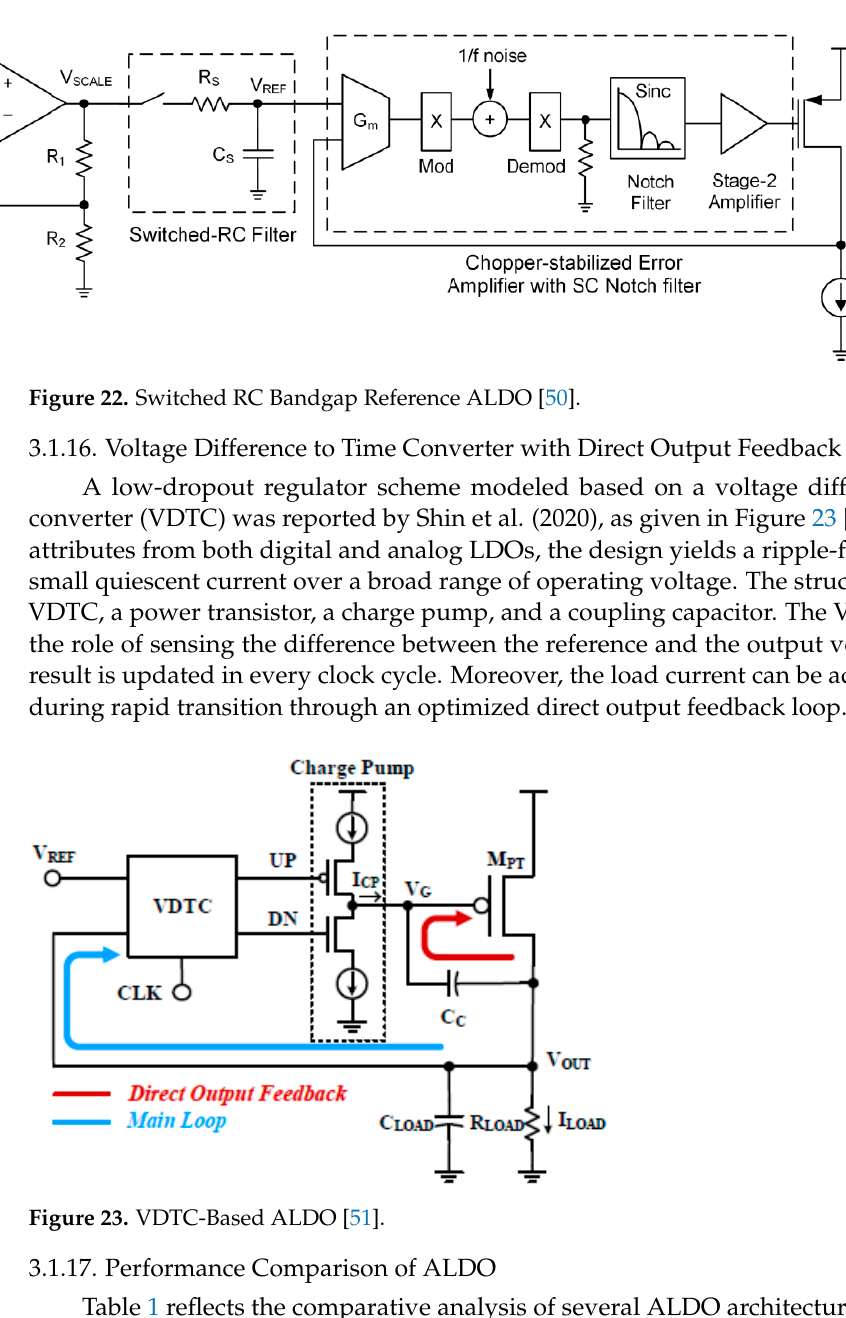
Figure 21. Multistage EA and PRDTRA-Based LDO [49].